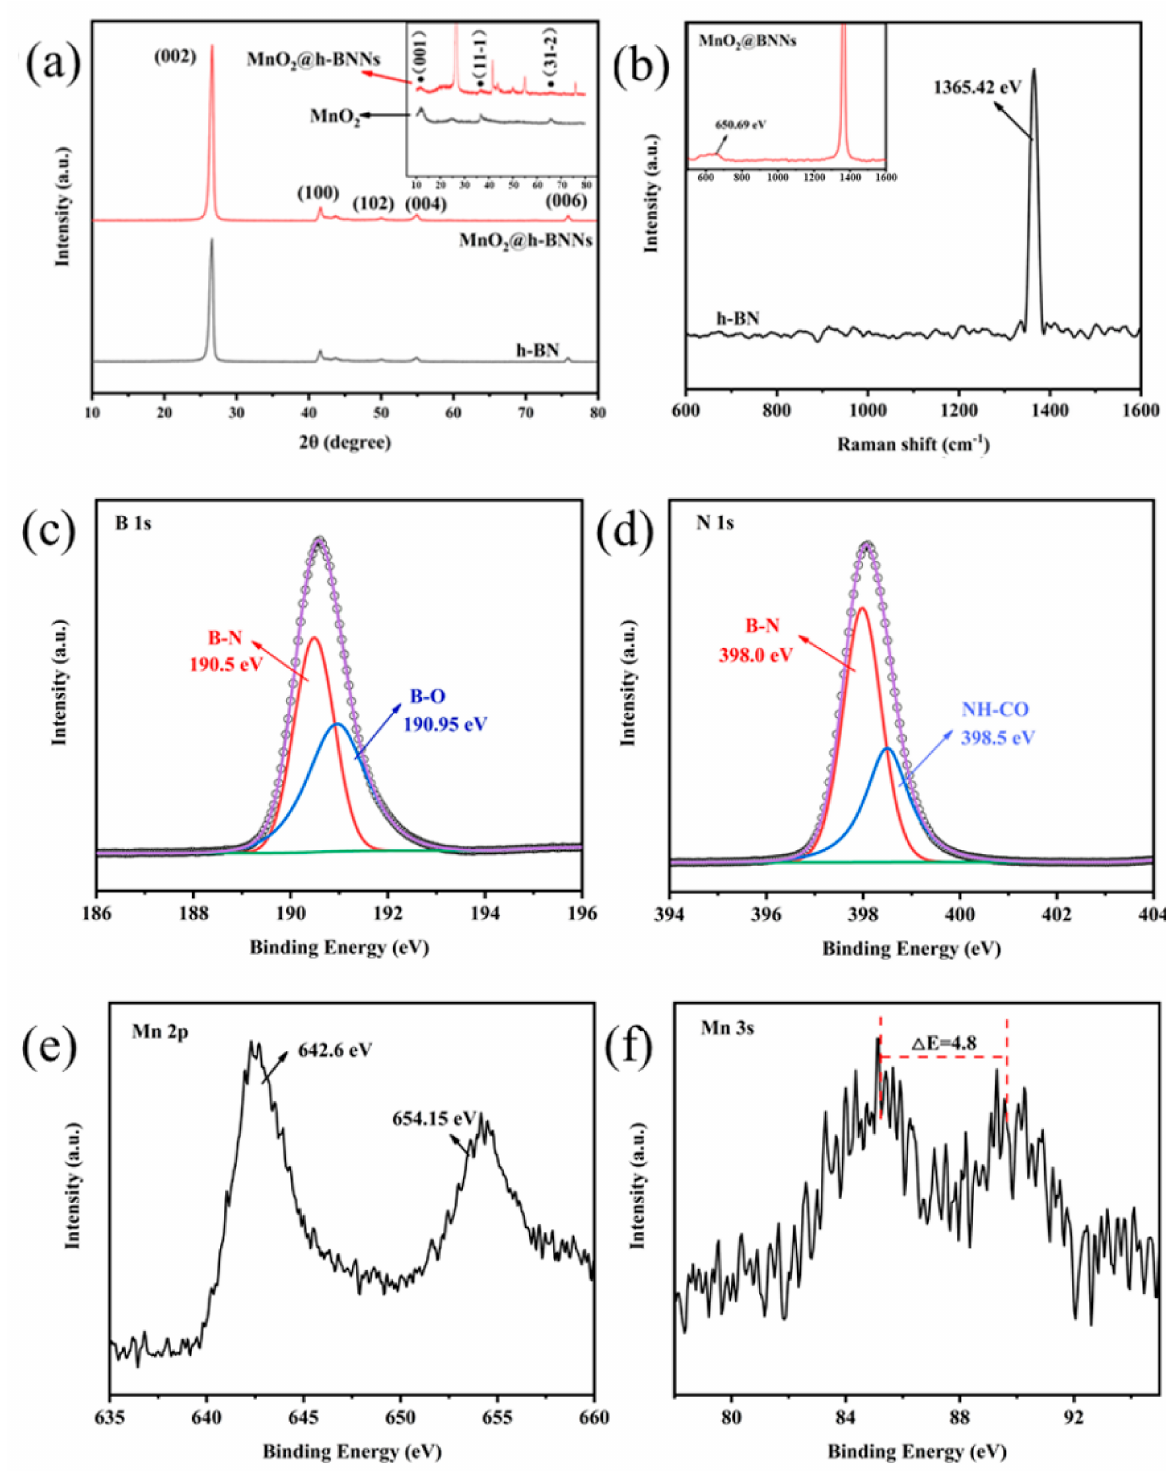
Figure 1. XPS fits of ( a ) XRD plots, ( b ) Raman spectra, and ( c ) B 1s, ( d ) N 1s, ( e ) Mn 2p, ( f ) Mn 3s of h-BN, and MnO 2